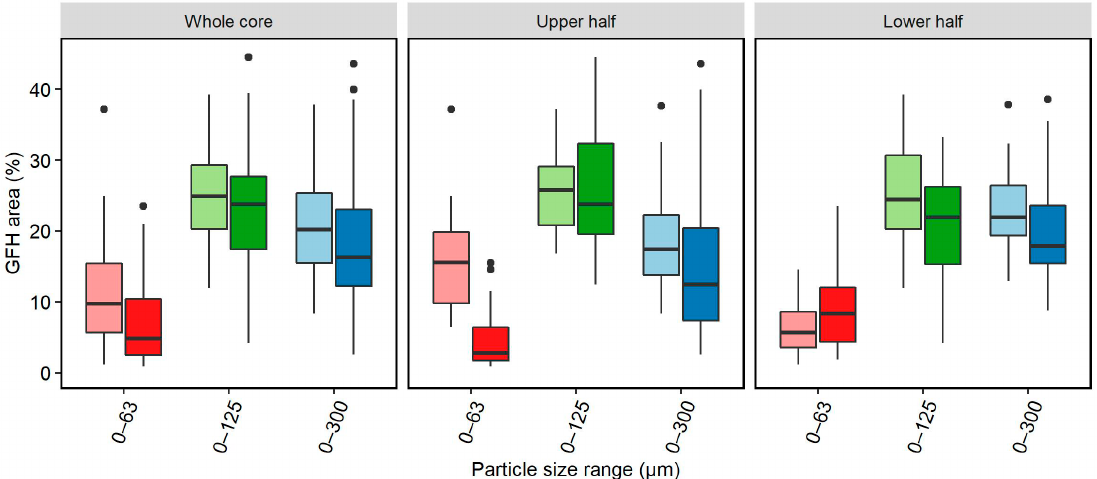
Figure 7. Cross-sectional area fractions covered by µ GFH in vertical distribution; same colors indicate Figure 7. Cross ‐ sectional area fractions covered by μ GFH in vertical distribution; same colors indicate duplicate duplicate columns.